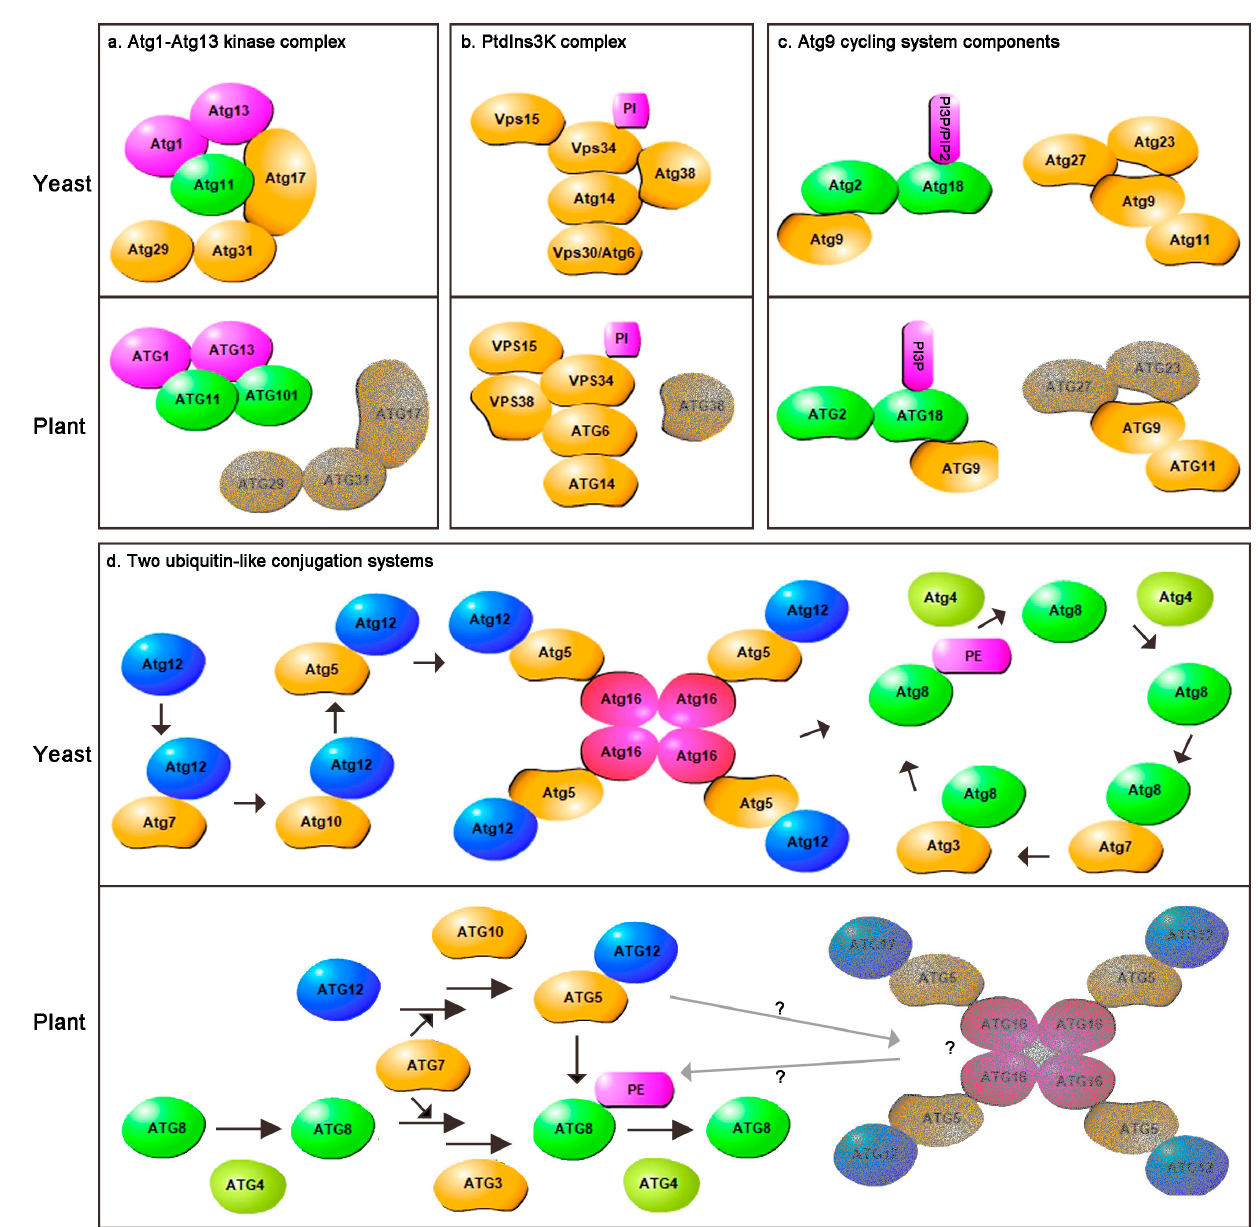
Figure 1. The comparison of yeast and Arabidopsis core autophagy components. ( a ) Atg1–Atg13 kinase complex. ( b ) The phosphatidylinositol 3-kinase (PtdIns3K) complex. ( c ) The Atg9 cycling system components. ( d ) The two ubiquitin-like conjugation systems. The unidentified components or complexes in plant are covered by grey.